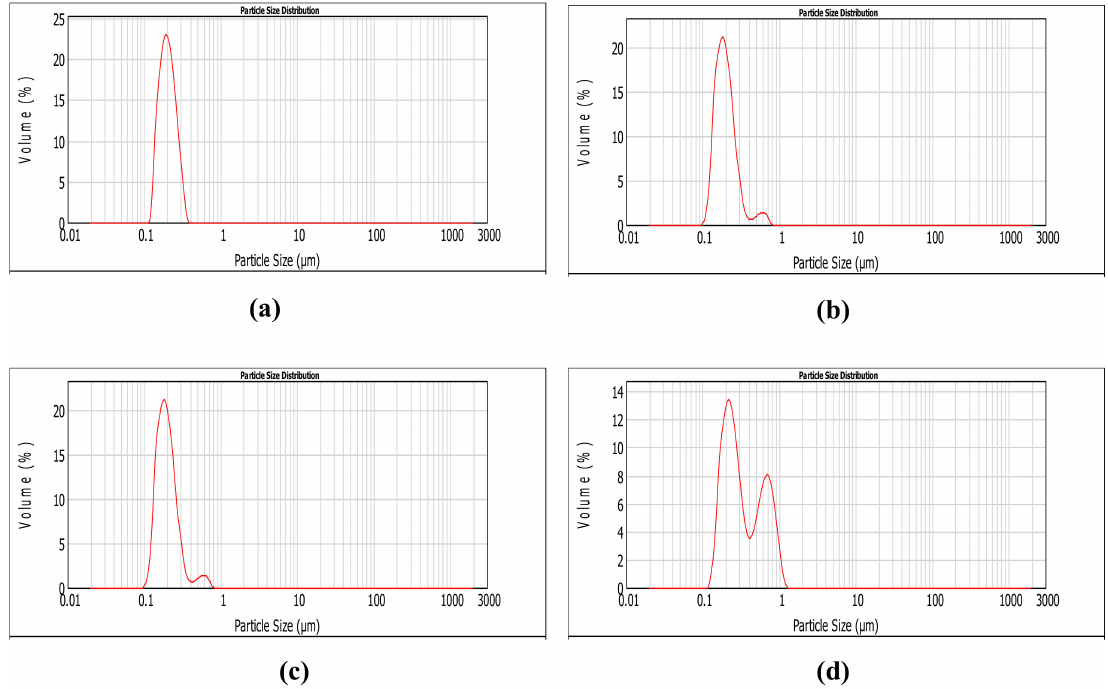
Figure 1. Particle size distribution by light scattering of coated liposomes. ( a ) QLL, ( b ) ICQLL, ( c ) LCQLL and ( d )